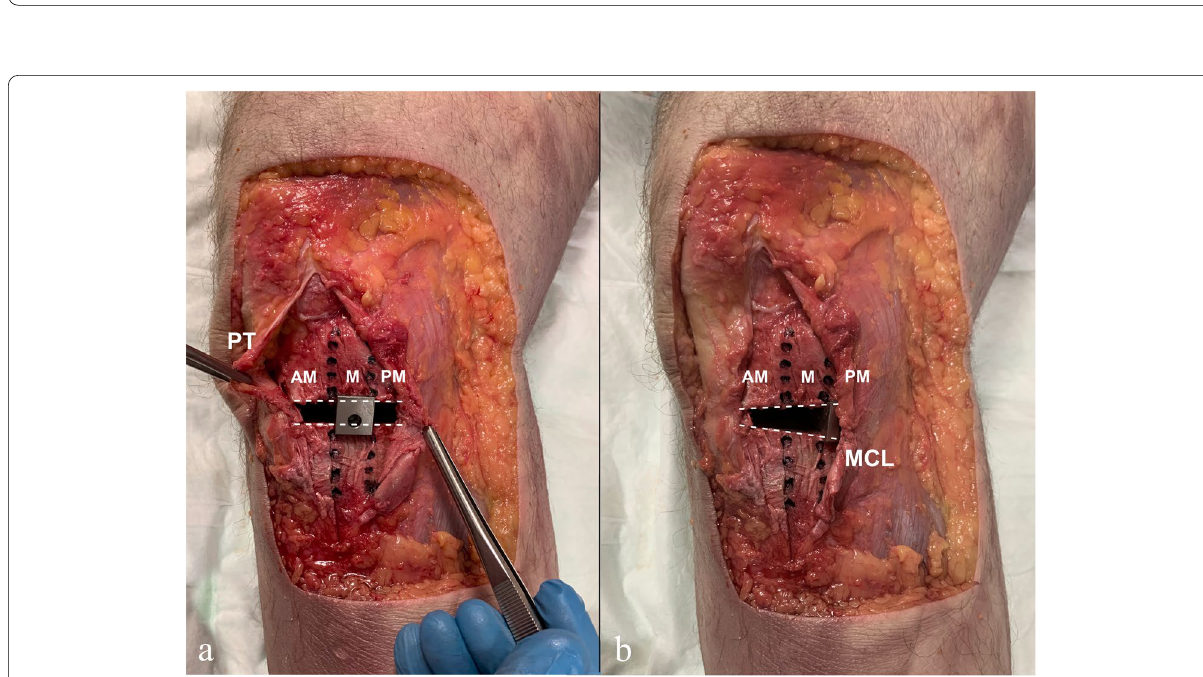
Fig. 3 Anteromedial view of the right knee, 4 cm case. The placement of the opening wedge in the M third of the tibia generates a parallel gap ( a ). In contrast, when the wedge is located in the PM third of the tibia, the result is an asymmetric gap. The extent to which the medial collateral ligament (MCL) may hinder the posterior placement of the opening wedge is also shown ( b ). PT, patellar tendon; AM, anteromedial; M, medial; PM,